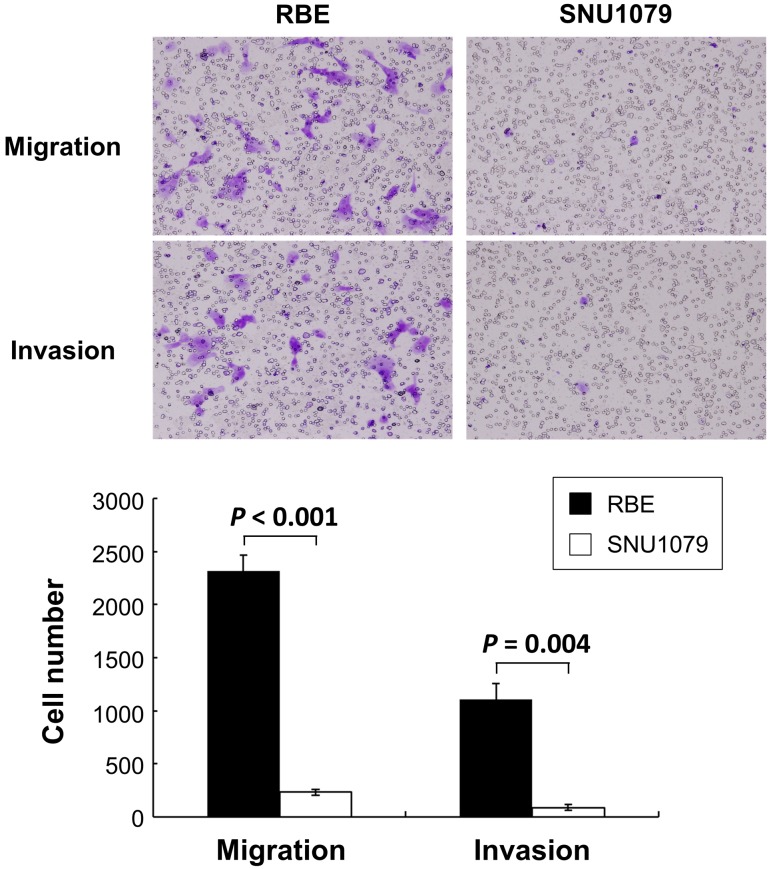
Cell line mobility potential.The RBE cell line demonstrated an increased number of migratory and invasive cells on the bottom of the wells. In contrast, the SNU1079 cell line containing a deletion of target genes displayed a significant decrease to mobility potential. Data represent means ± standard deviations for three independent experiments.